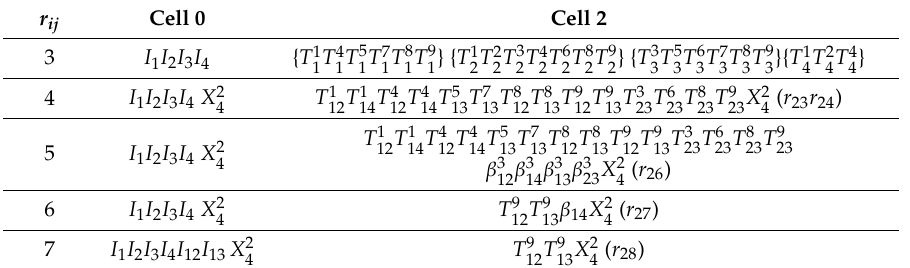
Table 4. Generation of frequent 2-patterns.